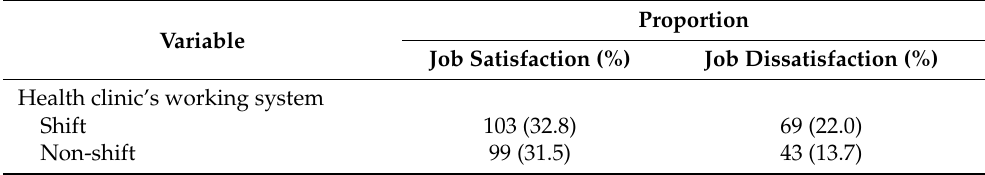
Table 3. Proportion of job dissatisfaction among healthcare workers working in different health clinics’ working systems ( n = 314).